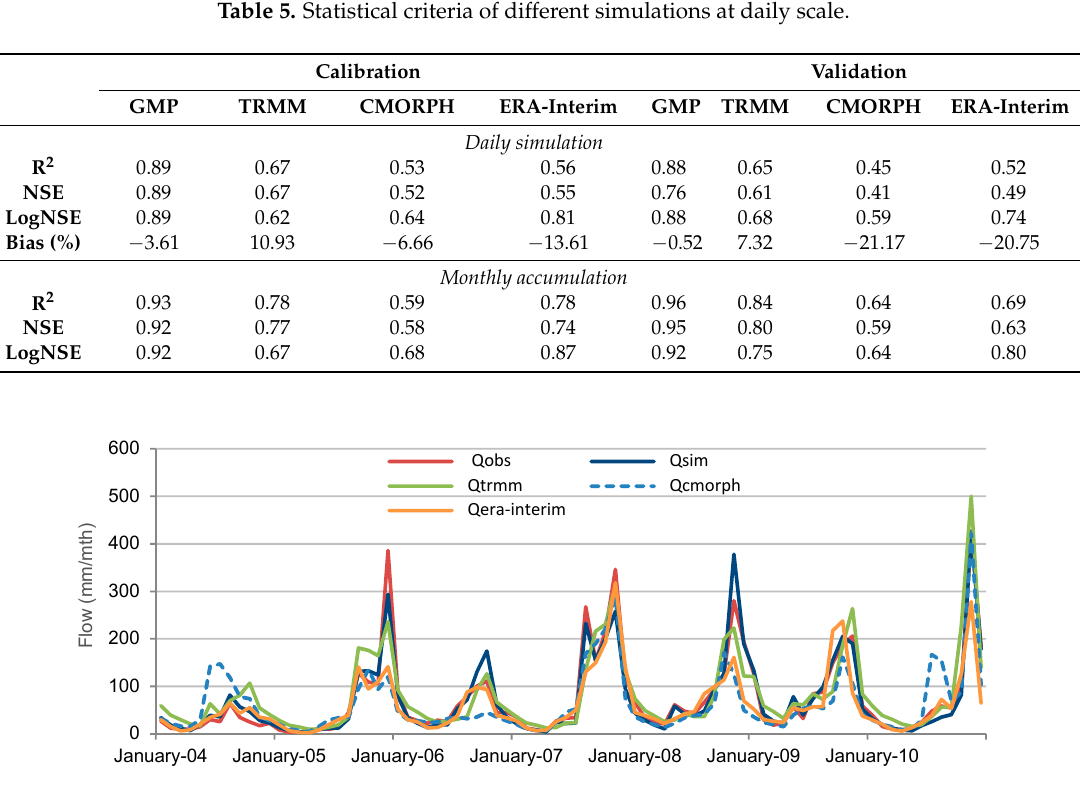
Figure 9. Hydrograph comparing average simulated and observed flow at monthly scale for calibration period (January 2004–December 2007) and validation period (January 2008–December 2010).